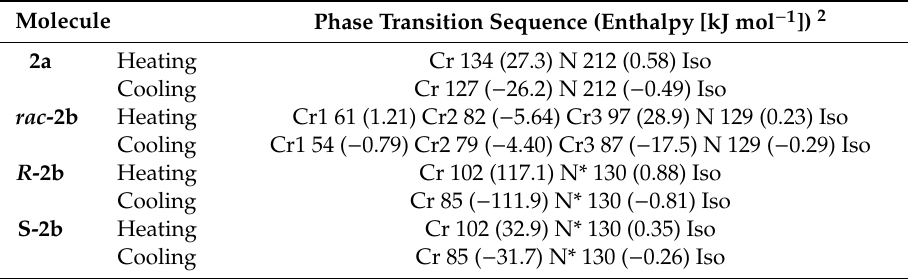
Table 2. Phase transition behaviors of 2a , rac - 2b , R - 2b , and S - 2b .